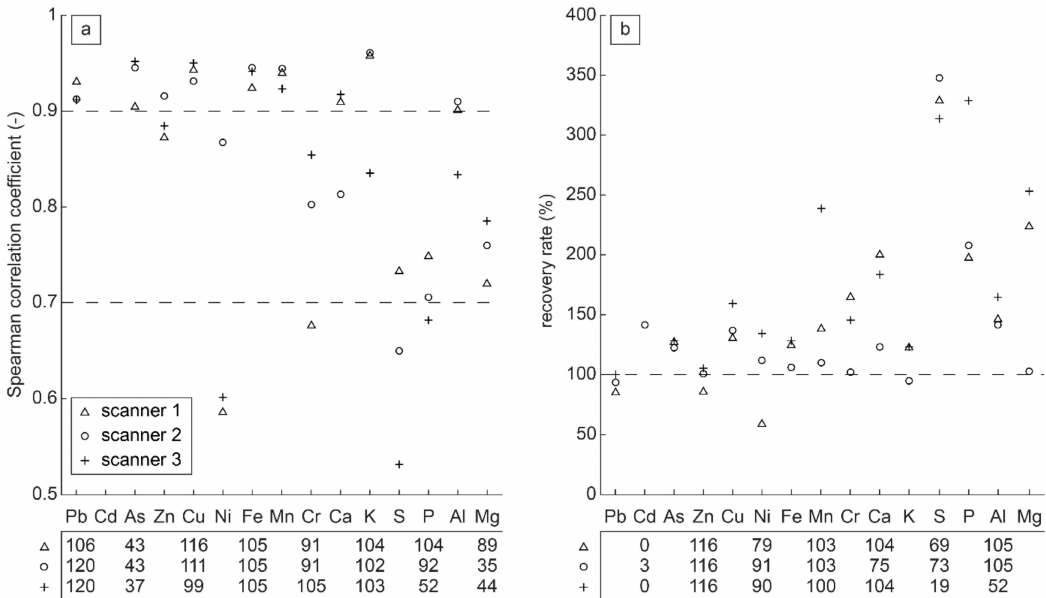
Figure 3. Calculated statistics. ( a ) Spearman correlation coe ffi cients; and ( b ) recovery rates for each element and each X-ray fluorescence (XRF) scanner. The atomic number (Z) of the elements decreases from left to right. Due to a lack of data, results could not be plotted for Cd measured with scanner 1 and 3. No significant correlation ( p < 0.05) was found for Cd with scanner 2 as the element was only detected in four samples. The number of soil samples used to calculate the correlations and recovery rates is given below the figures for each element and each scanner. Table 2. Data quality levels. X-ray fluorescence (XRF) data level quality for each scanner and each element based on significant ( p < 0.05) Spearman correlation coe ffi cients between XRF and